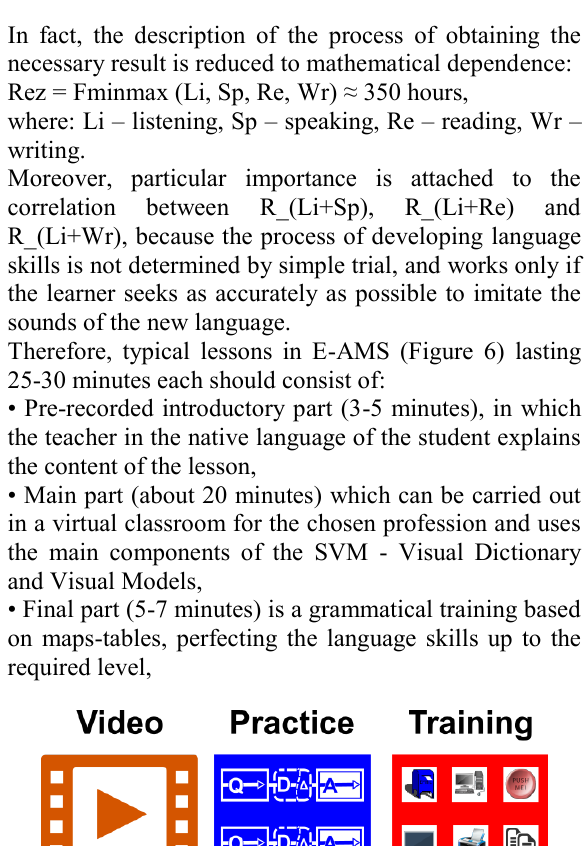
Fig. 5. Distribution of language competences.